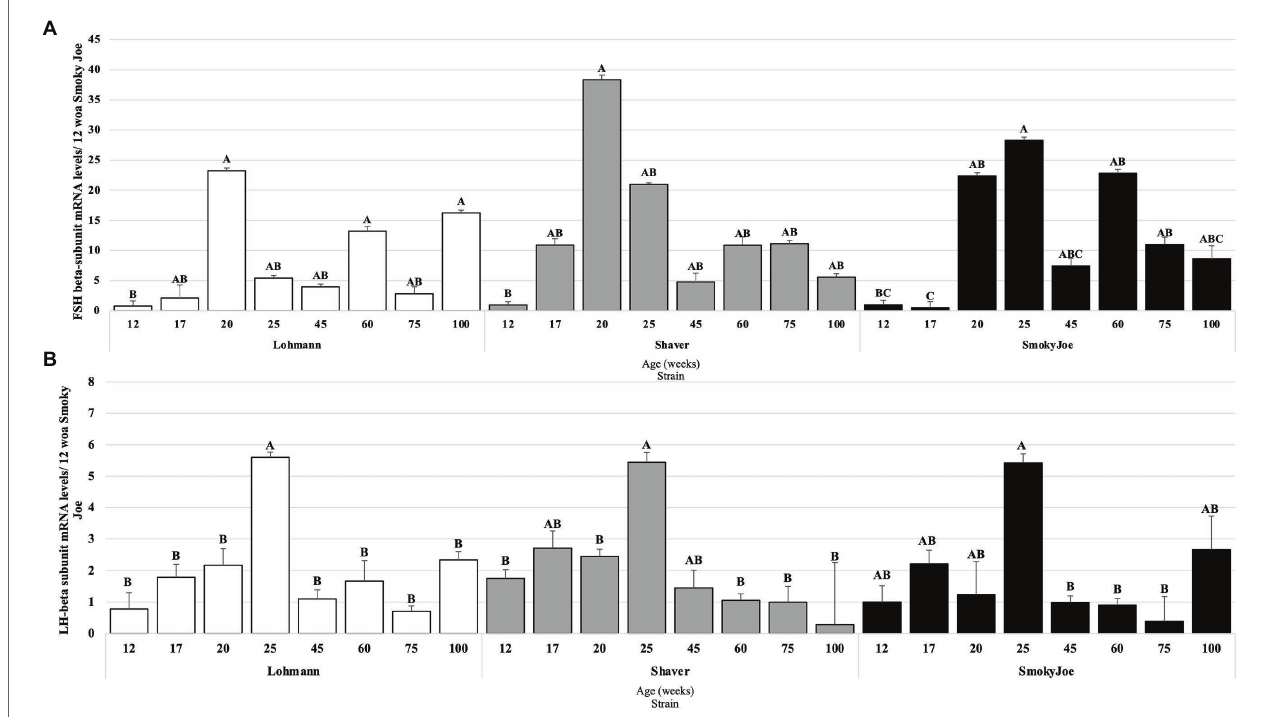
FIGURE 9 | Follicle-Stimulating Hormone (FSH; A ) and Luteinizing Hormone (LH; B ) mRNA expression levels in Lohmann, Shaver, and Smoky Joe hens at 12, 17, 20, 25, 45, 60, 75, and 100 woa. p -values for the sources of variation of age by strain: (A) Lohmann, p = 0.0013; Shaver, p = 0.0282; and Smoky Joe, p = 0.0153. (B) Lohmann, p = 0.0002; Shaver, p = 0.0055; and Smoky Joe, p = 0.0077. A,B,C Data points lacking the common superscript differ significantly within the ages of each strain, while no superscript did not differ from any other time point in that